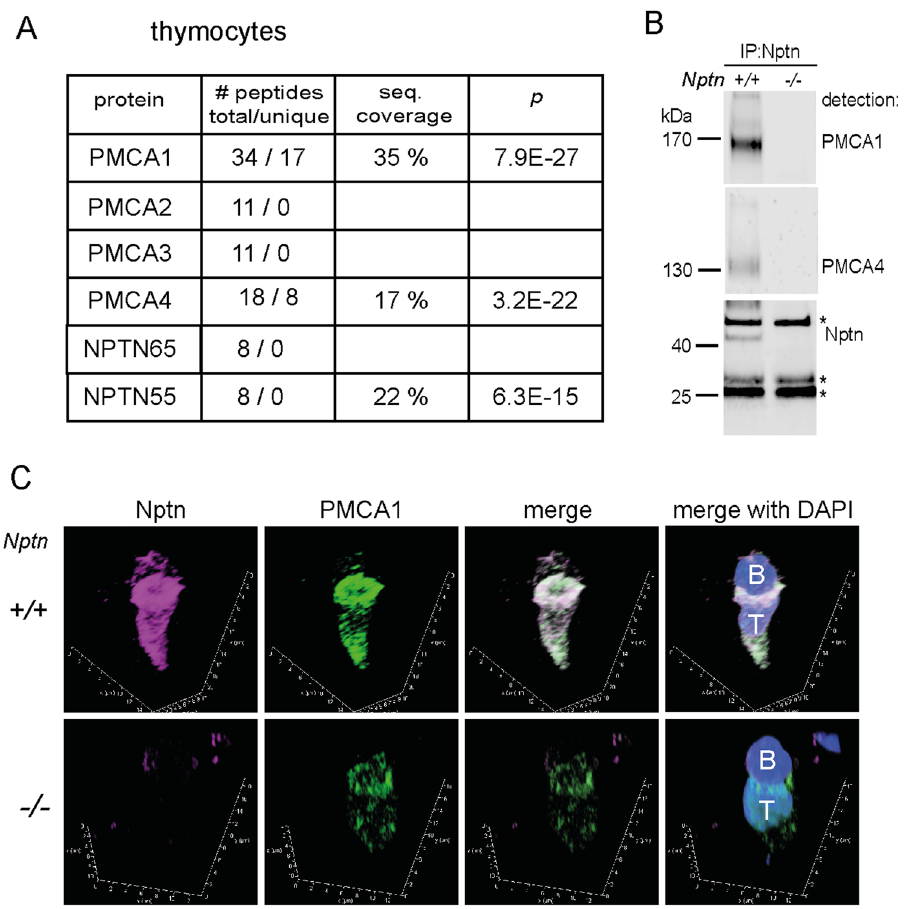
Figure 4. PMCA1 and PMCA4 are Neuroplastin-binding partners. ( A ) Table showing Neuroplastin interaction with PMCA1 and 4 in thymocytes revealed by MS of Neuroplastin-immunoprecipitates (IP) from wt thymocyte solubilizates. No unique peptides were detected for PMCA2 or 3. ( B ) Verification of the Neuroplastin-PMCA complex by Western blot detection of PMCA1 and 4 in Neuroplastin-IP. Asterisks mark immunoglobulin light and heavy chain bands. Nptn − / − control samples confirmed specificity. ( C ) Immunofluorescent double labeling of Neuroplastin (magenta) and PMCA1 (green) and co-staining for DNA (DAPI, blue) on conjugates formed between pOva-loaded B cells and OT-II transgenic wt (upper panel) or Nptn − / − (lower panel) CD4 T cell blasts, scanned at 63x magnification and shown as 3D reconstructions from confocal stacks. Merged images reveal striking co-localization (white) of both proteins at the synaptic interface between the elongated wt T cell (T) and the weakly labeled B cell (B). Note that reduced PMCA1 in Nptn − / − T cells still enriches at the immune